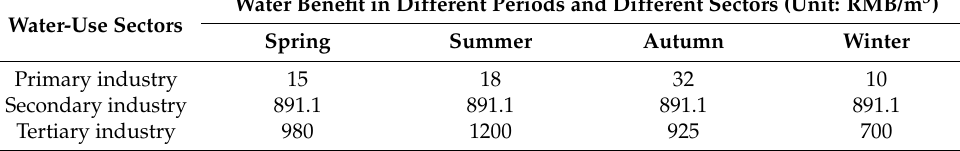
Table 5. The penalty of each water-use department in four planning periods.